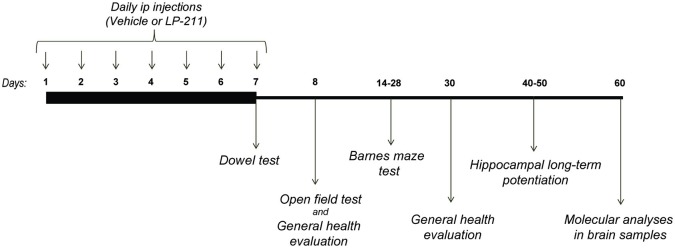
Experimental Design.